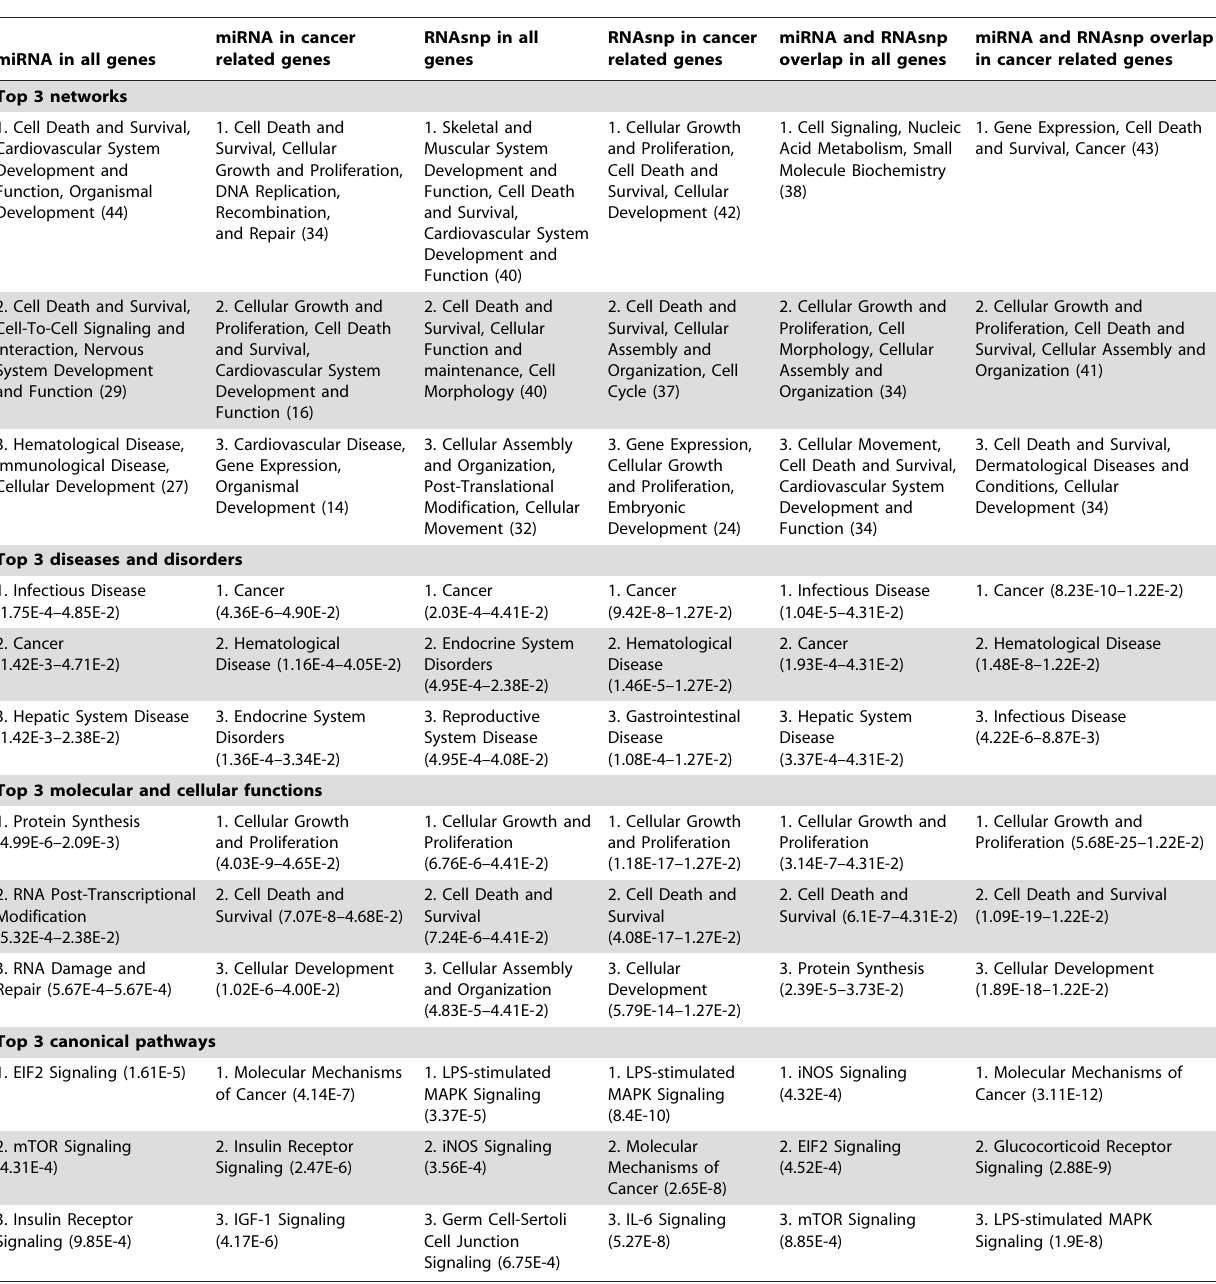
Table 7. Summary of pathway analysis results using Ingenuity pathway analysis software.